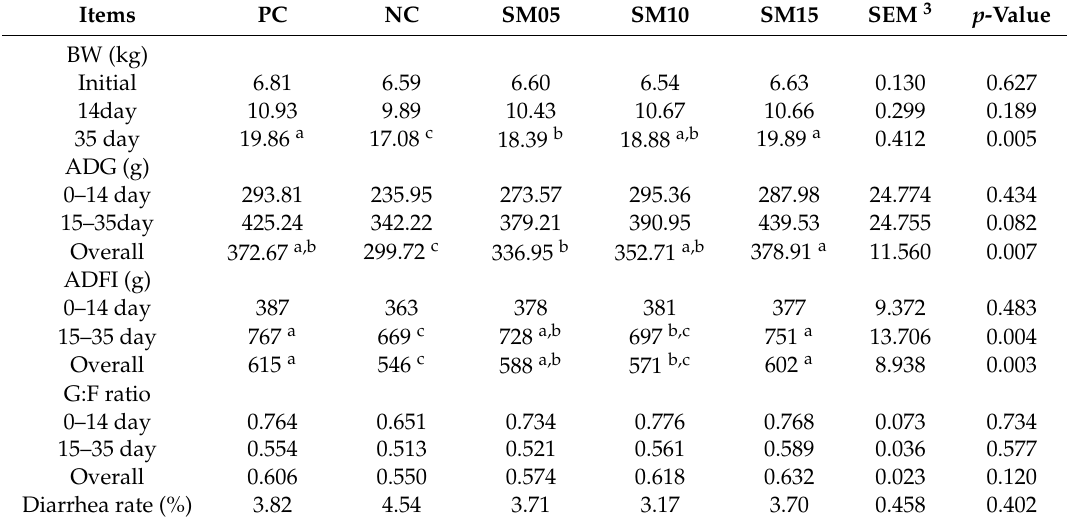
Table 3. E ff ect of spent mushroom ( C. militaris ) on growth performance and diarrhoea occurrence in weaning pig 1,2 .